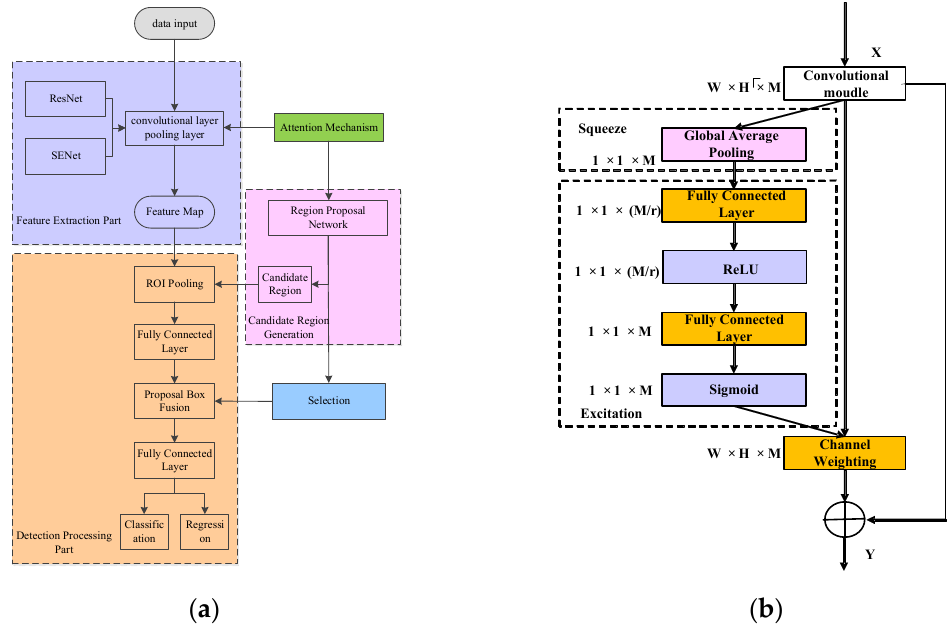
Figure 7. ( a ) Structure of crack image detection model based on attention mechanism. ( b ) Residual unit embedded SENet.